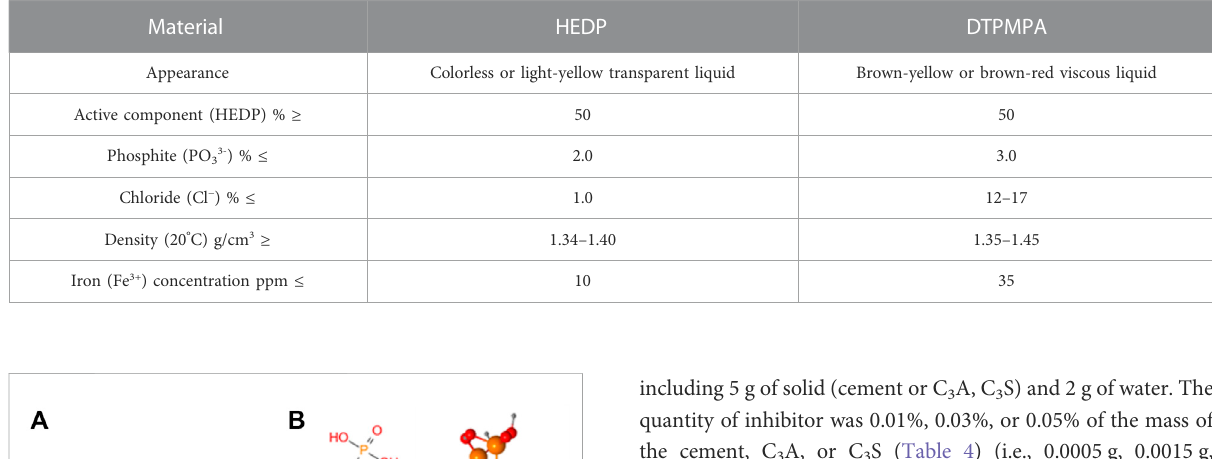
TABLE 1 Characteristics of the hydration heat inhibitors tested in this study.